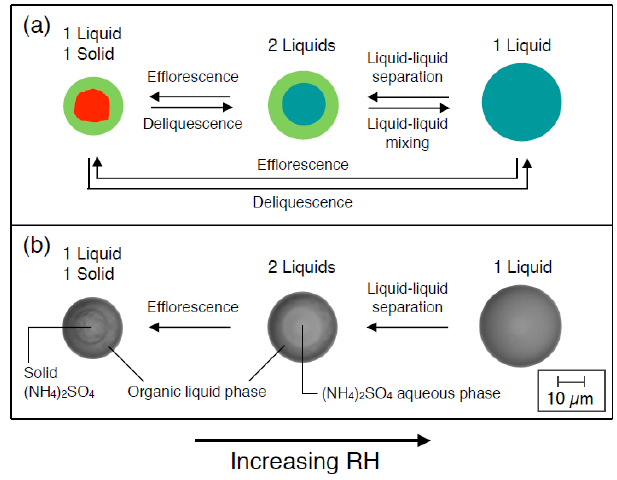
Figure 8. (a) Some of the phase transitions which may occur for in- ternally mixed atmospheric particles consisting of ( NH 4 ) 2 SO 4 and organic materials. Aqua represents an aqueous phase, green repre- sents a liquid phase of organic material, and red presents a solid phase of ( NH 4 ) 2 SO 4 . (b) Optical microscopic images of a parti- cle which contained ( NH 4 ) 2 SO 4 and 1,2,6-trihydroxyhexane with a mass ratio of 1 : 2 . 1, during an experiment in which temperature was kept at around 291K, while RH was decreased. Reprint with permission by Bertram et al.